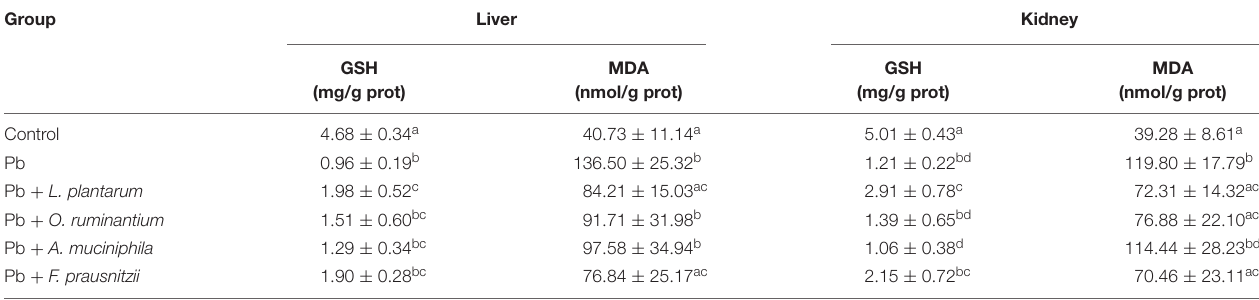
TABLE 3 | The effects of Pb-intolerant gut microbes on the contents of MDA and GSH in the liver and kidneys of chronically Pb-exposed mice. Group